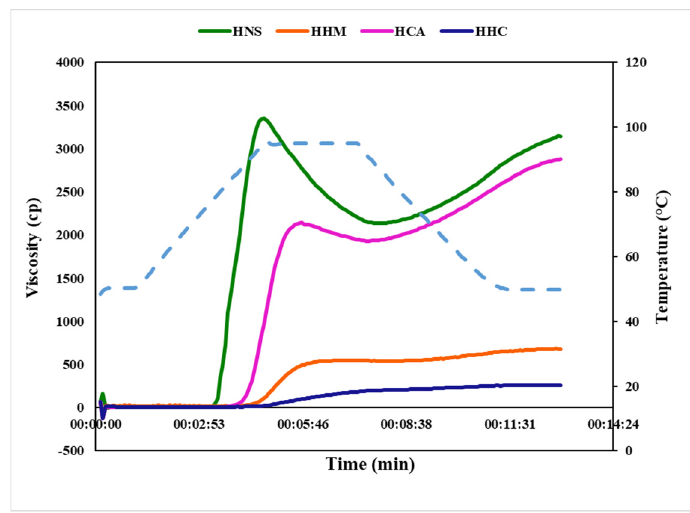
Figure 3. Pasting profile of native and modified Hausa potato